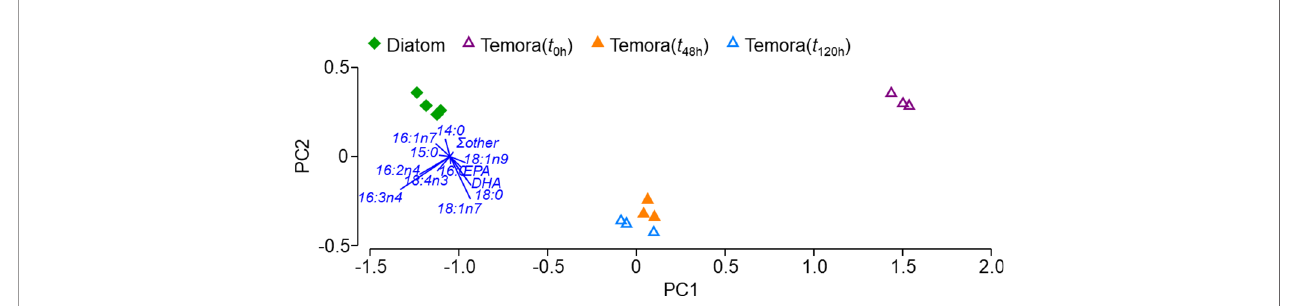
FIGURE 1 | Principal component analysis (PCA) illustrating the relative FA pro fi le (for FAs >1% TFA and the sum of FAs <1% TFA) of copepods (at the three sampling times) and of their diatom prey. Important FAs for characterizing overall FA pro fi le were overlaid